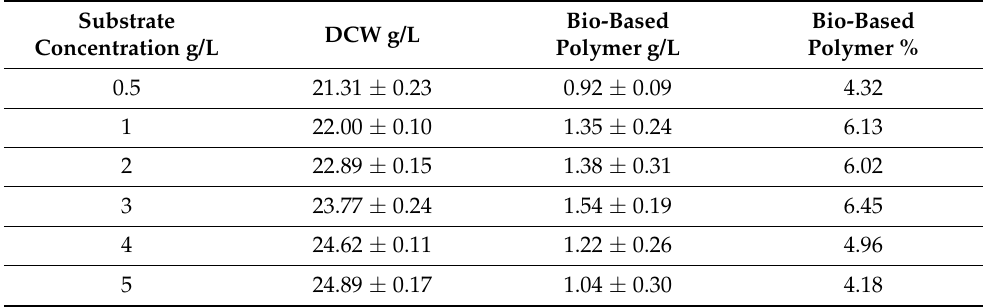
Table 4. Effect of increasing substrate concentrations on the PHB bio-based polymer final